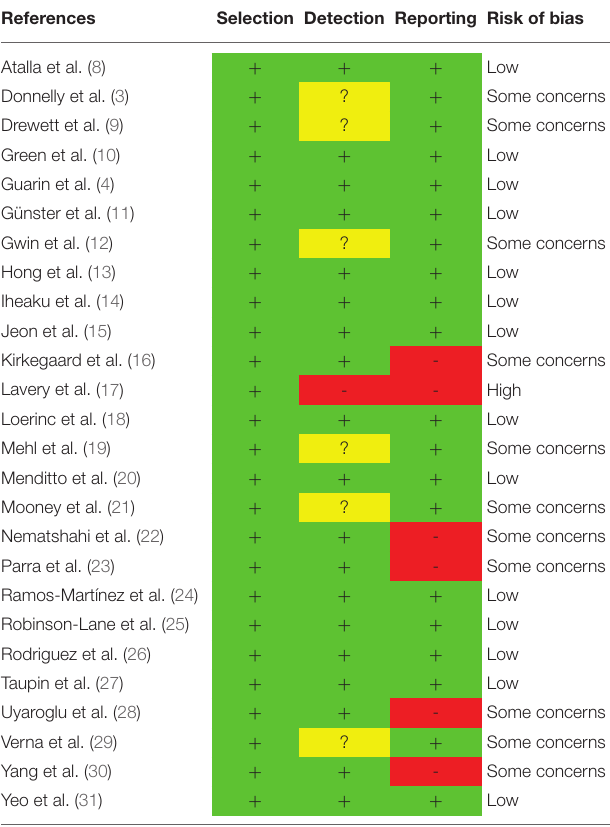
TABLE 1 | Risk of bias assessment table. statistics method. All three studies show that the readmission rate is around 5% in Spain (4.2%, 4.4%, and 5.4%), One study shows that 0.73% died during the first month